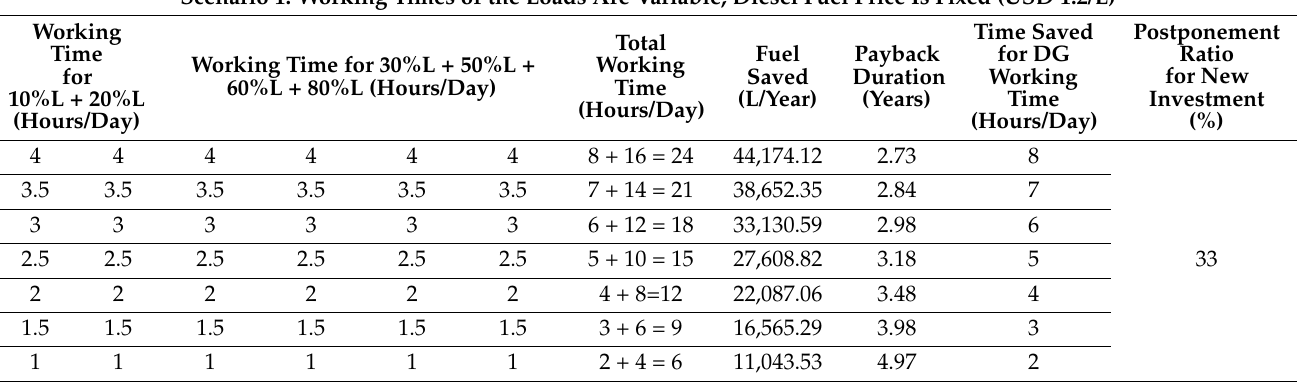
Table 2. Payback time with varying working hours (scenario 1).